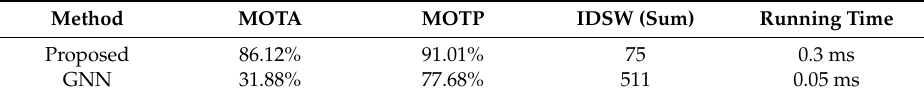
Table 6. Overall evaluation results.